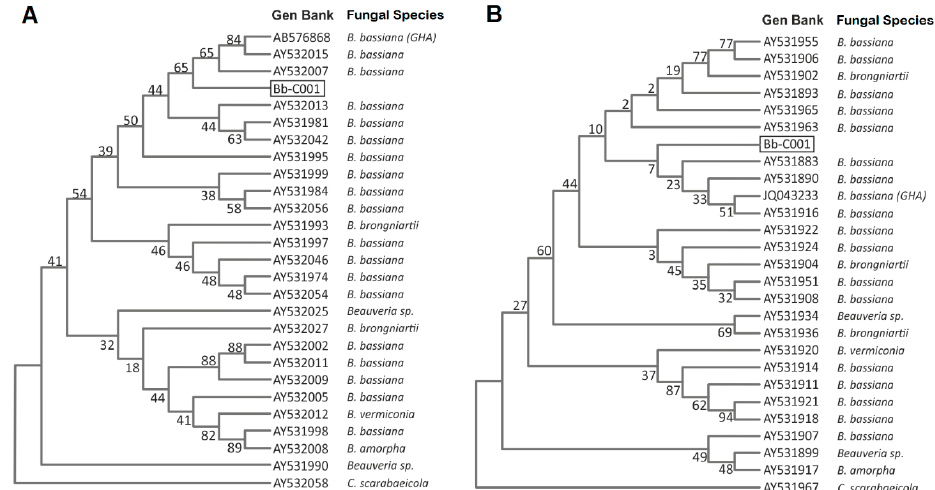
Figure 1. Phylogenetic tree generated by the maximum likelihood analysis of the ribosomal internal transcribed spacer (ITS) ( A ), and elongation factor 1- α (EF1- α ) ( B ) sequences of Beauveria bassiana Bb-C001 (boxed) and related isolates. The fungal isolates, origin and access numbers to the GenBank are detailed. Numbers on branches are bootstrap support from 1000 replicates.